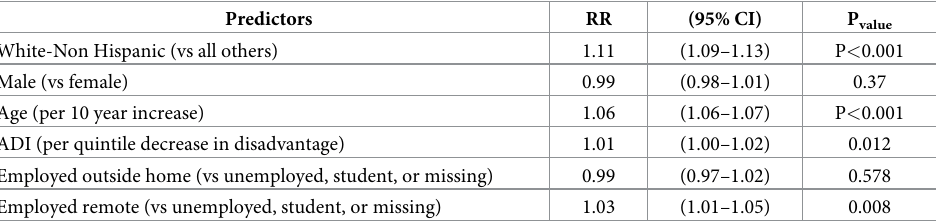
Table 2. Longitudinal retention & engagement based on kit